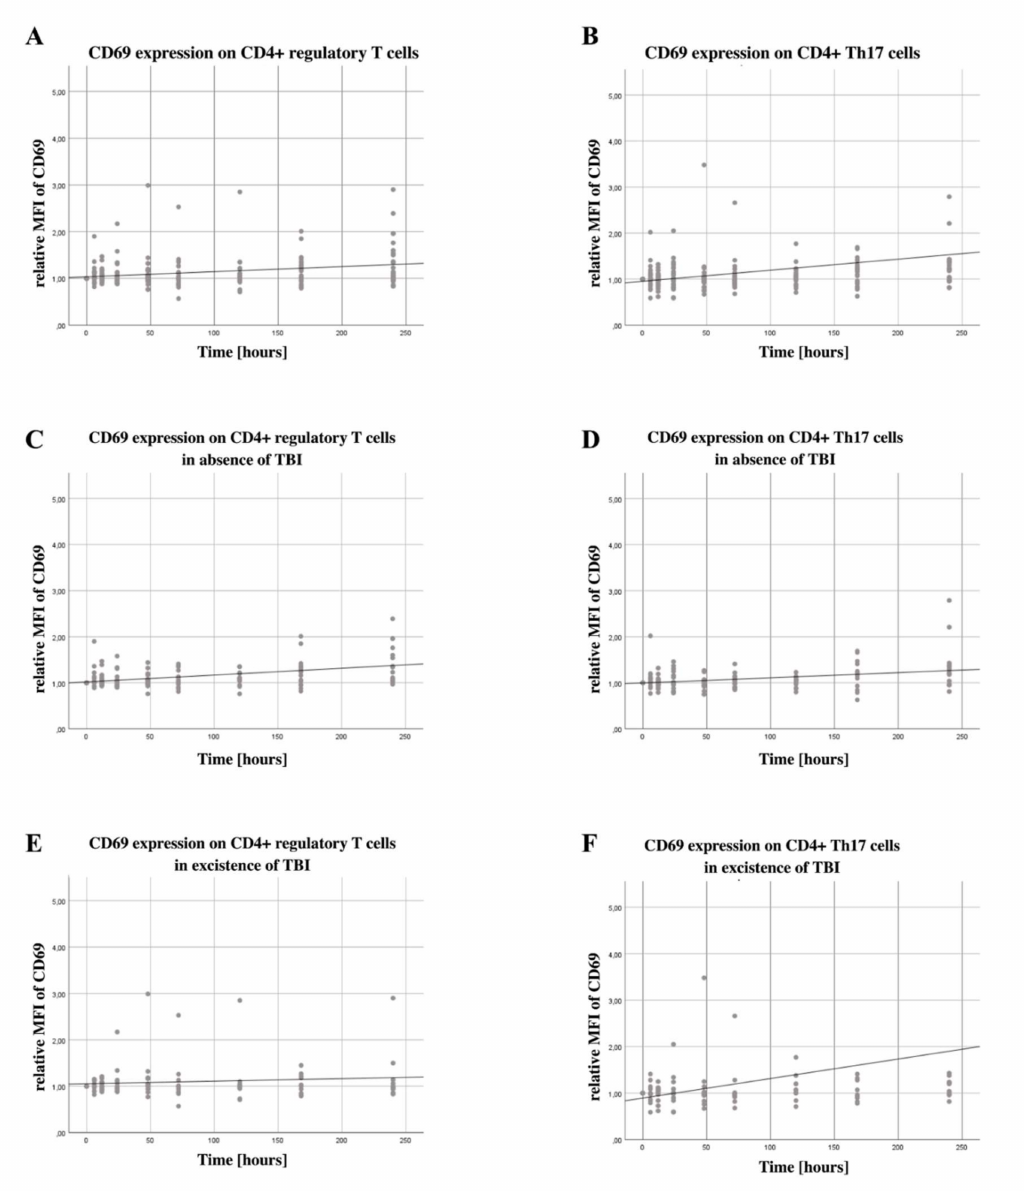
Figure 1. CD69 expression on CD4+ regulatory T cells and Th 17cells over the first ten days after trauma in patients with and without severe TBI . ( A ) The CD69 expression on CD4+ Tregs and Th17 cells was measured via flow cytometry using PE-conjugated anti-CD69 antibodies. CD4+ Tregs were defined as CD4+, CD25+ and CD127low. Th17 cells were defined as CD4+, CD161+ and CD196+. Blood was drawn on arrival at the emergency room (0), after 6, 12, 24 and 72 h, as well as after 5, 7 and 10 days. During this time, we found a significant increase in CD69 expression on CD4 Tregs (B = 0.033, SE = 0.0087, 95% CI [0.016, 0.050], p < 0.001), ( B ) but not on Th17 cells (B = 0.058, SE = 0.0347, 95% CI [ − 0.010, − 0.0126, p = 0.093). ( C ) Looking at the population with absence of severe TBI, we were able to determine a significant increase in the expression of CD69 on CD4+ Tregs (B = 0.040, SE = 0.0080, 95% CI [0.024, 0.056], p < 0.001) and ( D ) Th17 cells (B = 0.028, SE = 0.0093, 95% CI [0.010, 0.046], p = 0.003). ( E ) The population of severe TBI patients had no significant change in the time span of 10 days in the expression of CD69 on CD4+ Tregs (B = 0.020, SE = 0.0163, 95% CI [ − 0.011, 0.052], p = 0.202) and ( F ) Th17 cells (B = 0.101, SE = 0.0791, 95% CI [ − 0.054, 0.256], p = 0.202). The regression line shown here is for illustrative